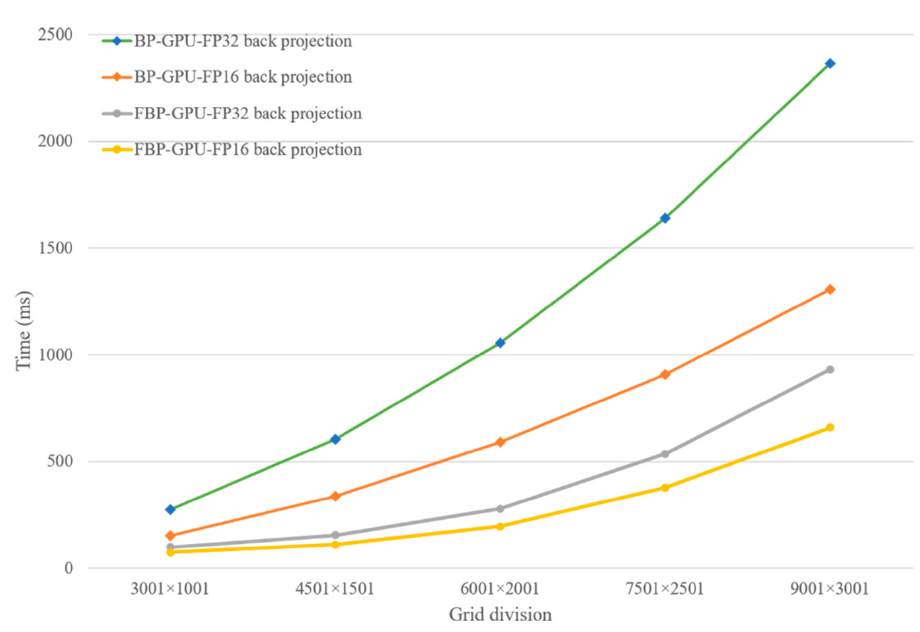
Figure 12. Time of the back projection of different grid divisions.